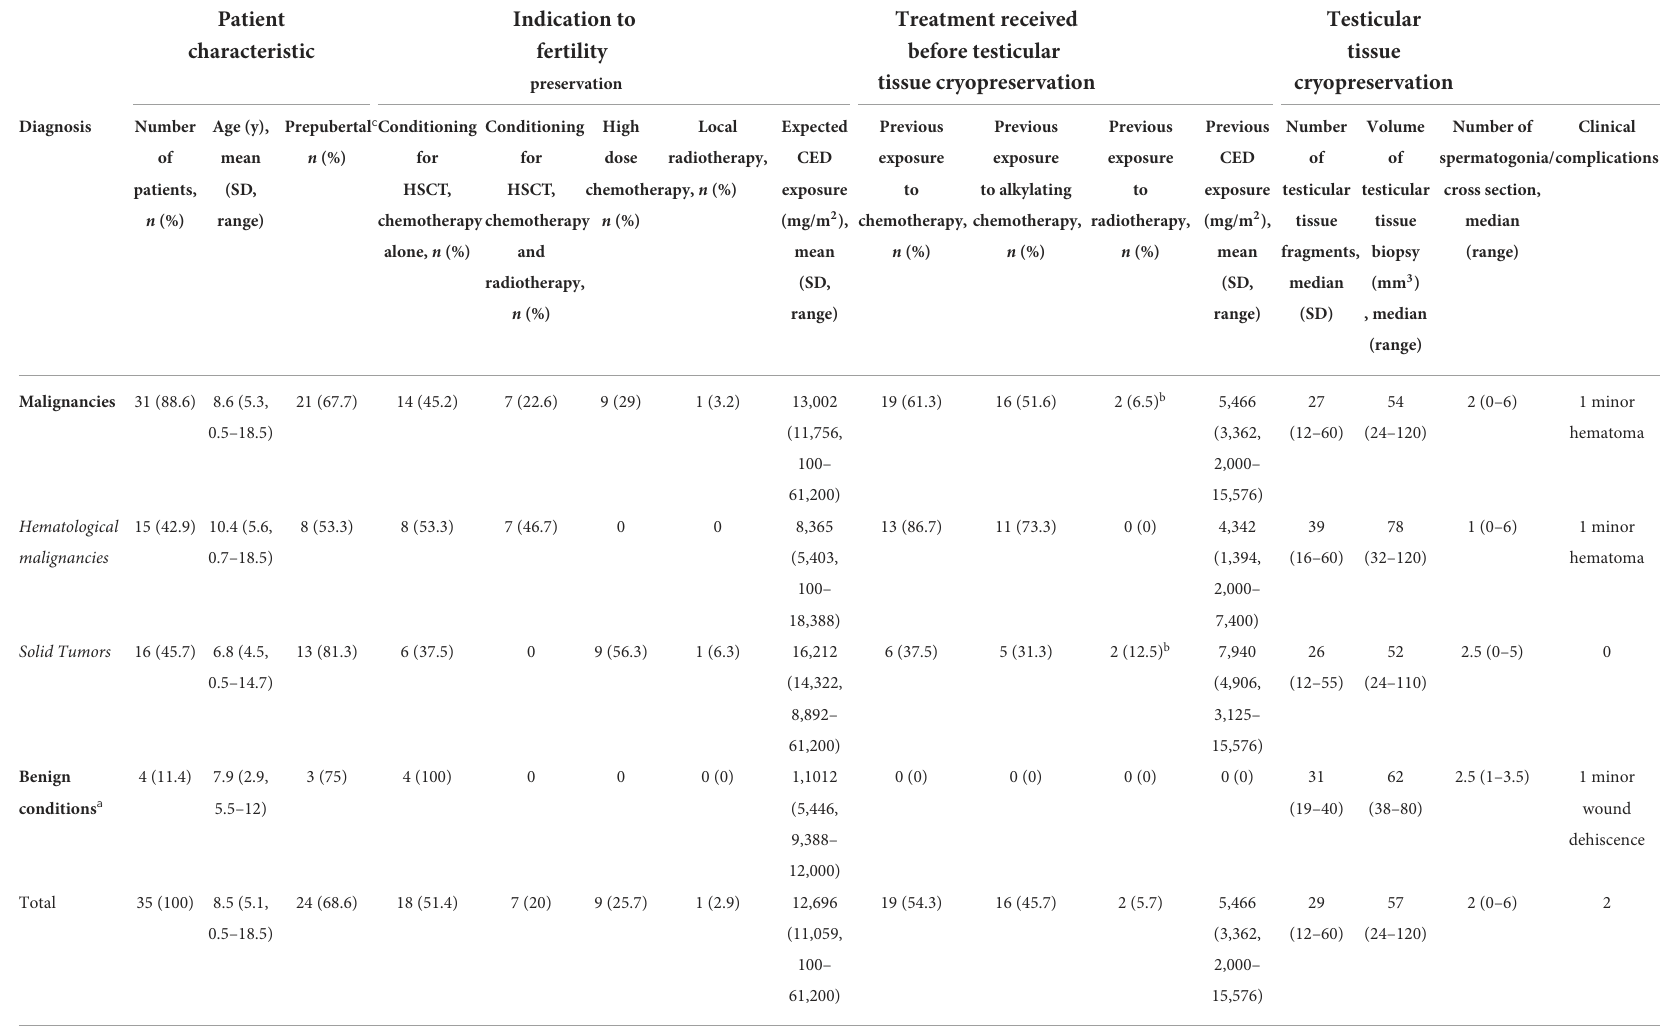
TABLE 2 Patient characteristics, indication for testicular tissue cryopreservation (TTC), treatment received before TTC, amount of retrieved tissue, and clinical complications. CED exposure was based on the cyclophosphamide equivalent dose calculator